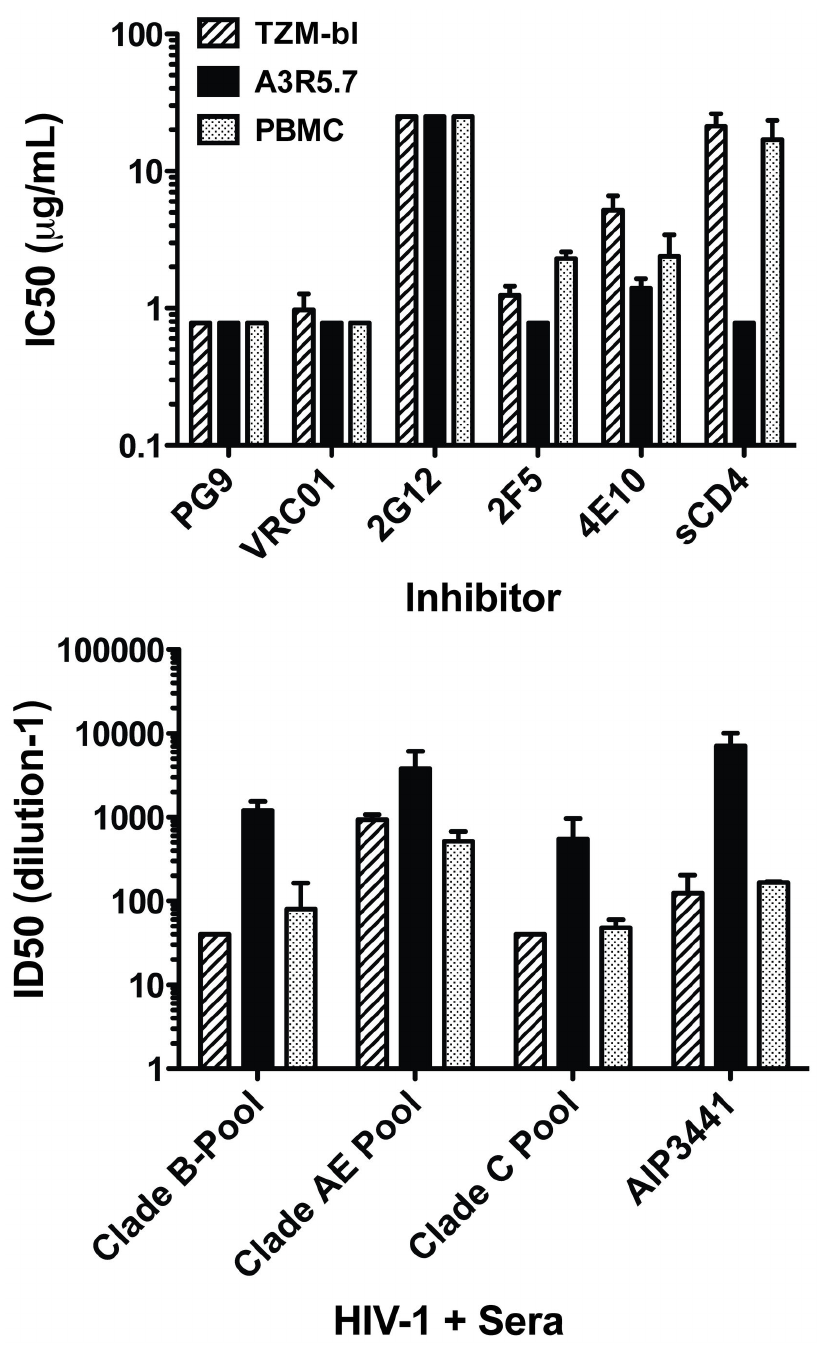
Figure 4. Neutralization of a tier 2 CRF_01 AE IMC.LucR virus in A3R5.7, TZM-bl and CD3.8 bi-specific antibody stimulated PBMC cell targets. A . Neutralization with epitope-specific inhibitors . NL.LucR-CM235.ecto was tested against a panel of monoclonal antibodies and sCD4 in each cell line. The highly potent PG9 ad VRC01 mAbs demonstrated IC50 titers below the limits of the assay (<0.78μg/mL). This chronic envelope IMC was insensitive to 2G12 (>25μg/mL) in all target cells. NL.LucR-CM235.ecto was more sensitive to the inhibitors 2F5, 4E10 and sCD4 in the A3R5.7 target cell compared to both TZM-bl and PBMC, reaching significance with sCD4 (Unpaired t-test with Welch correction; p<0.05). Inhibitors ranged from 0.78μg/mL to 25 μg/mL. B . Neutralization with polyclonal sera . NL.LucR-CM235.ecto was tested against a panel of pooled HIV-1 “+” sera/plasma and the individual AE-specific sera AIP3441 in each cell line. Sera dilutions ranged from 40-40,960. All sera appeared more potent in the A3R5.7 cell line compared to either TZM-bl or PBMC. doi: 10.1371/journal.pone.0077756.g004 PLOS ONE |